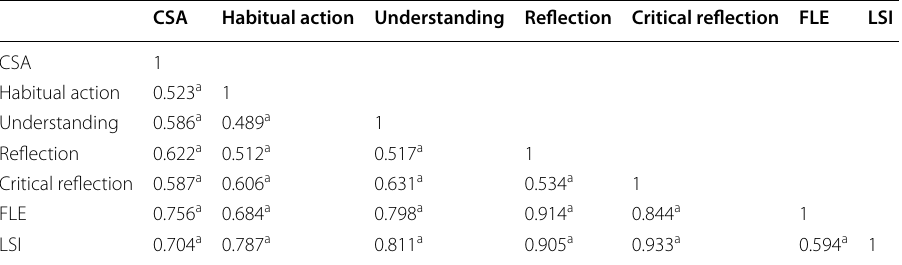
a Correlation is significant at the 0.01 level (2-tailed)